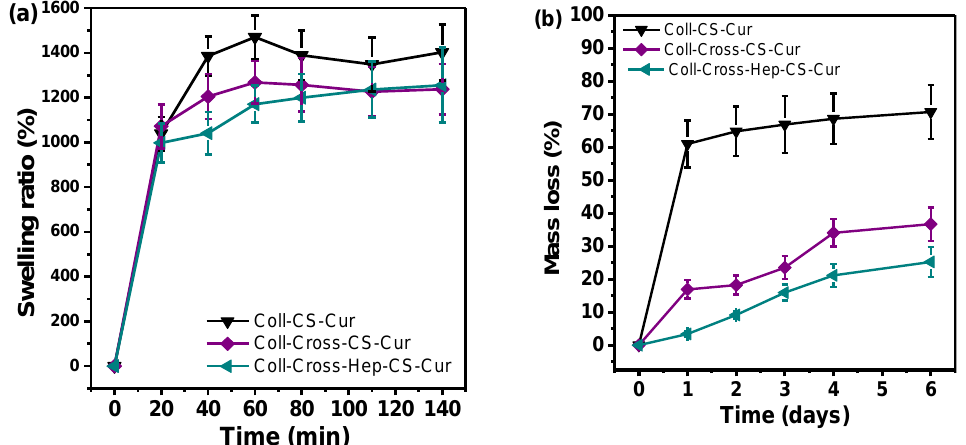
Figure 7. ( a ) Swelling ratio and ( b ) mass loss during the enzymatic hydrolysis of collagen patches with CS-NPs.